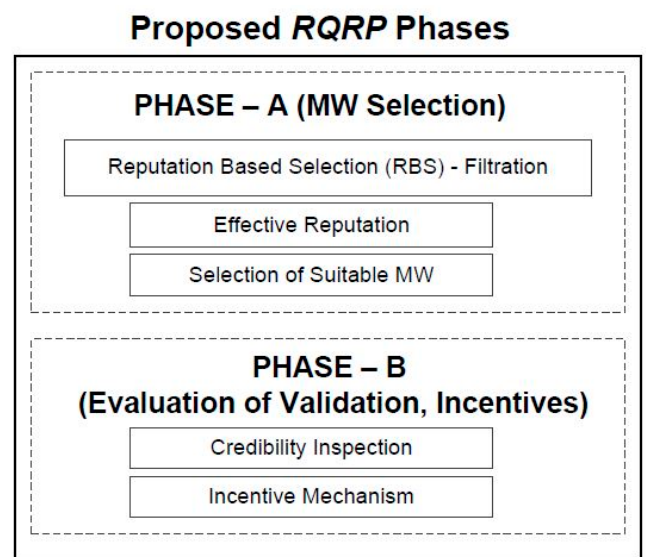
Figure 2. Phases of proposed RQRP for MW selection ( top ) and evaluating validation and incentives ( bottom